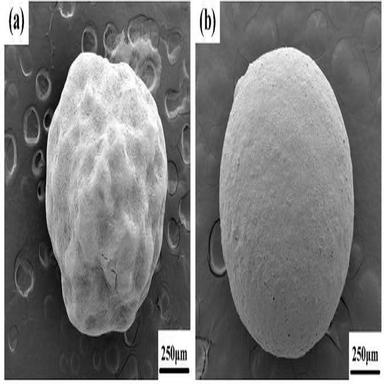
SEM morphology of the core-shell green pebbles prepared by (a) conventional rolling coating method and (b) chitosan-assisted rolling coating method, respectively.